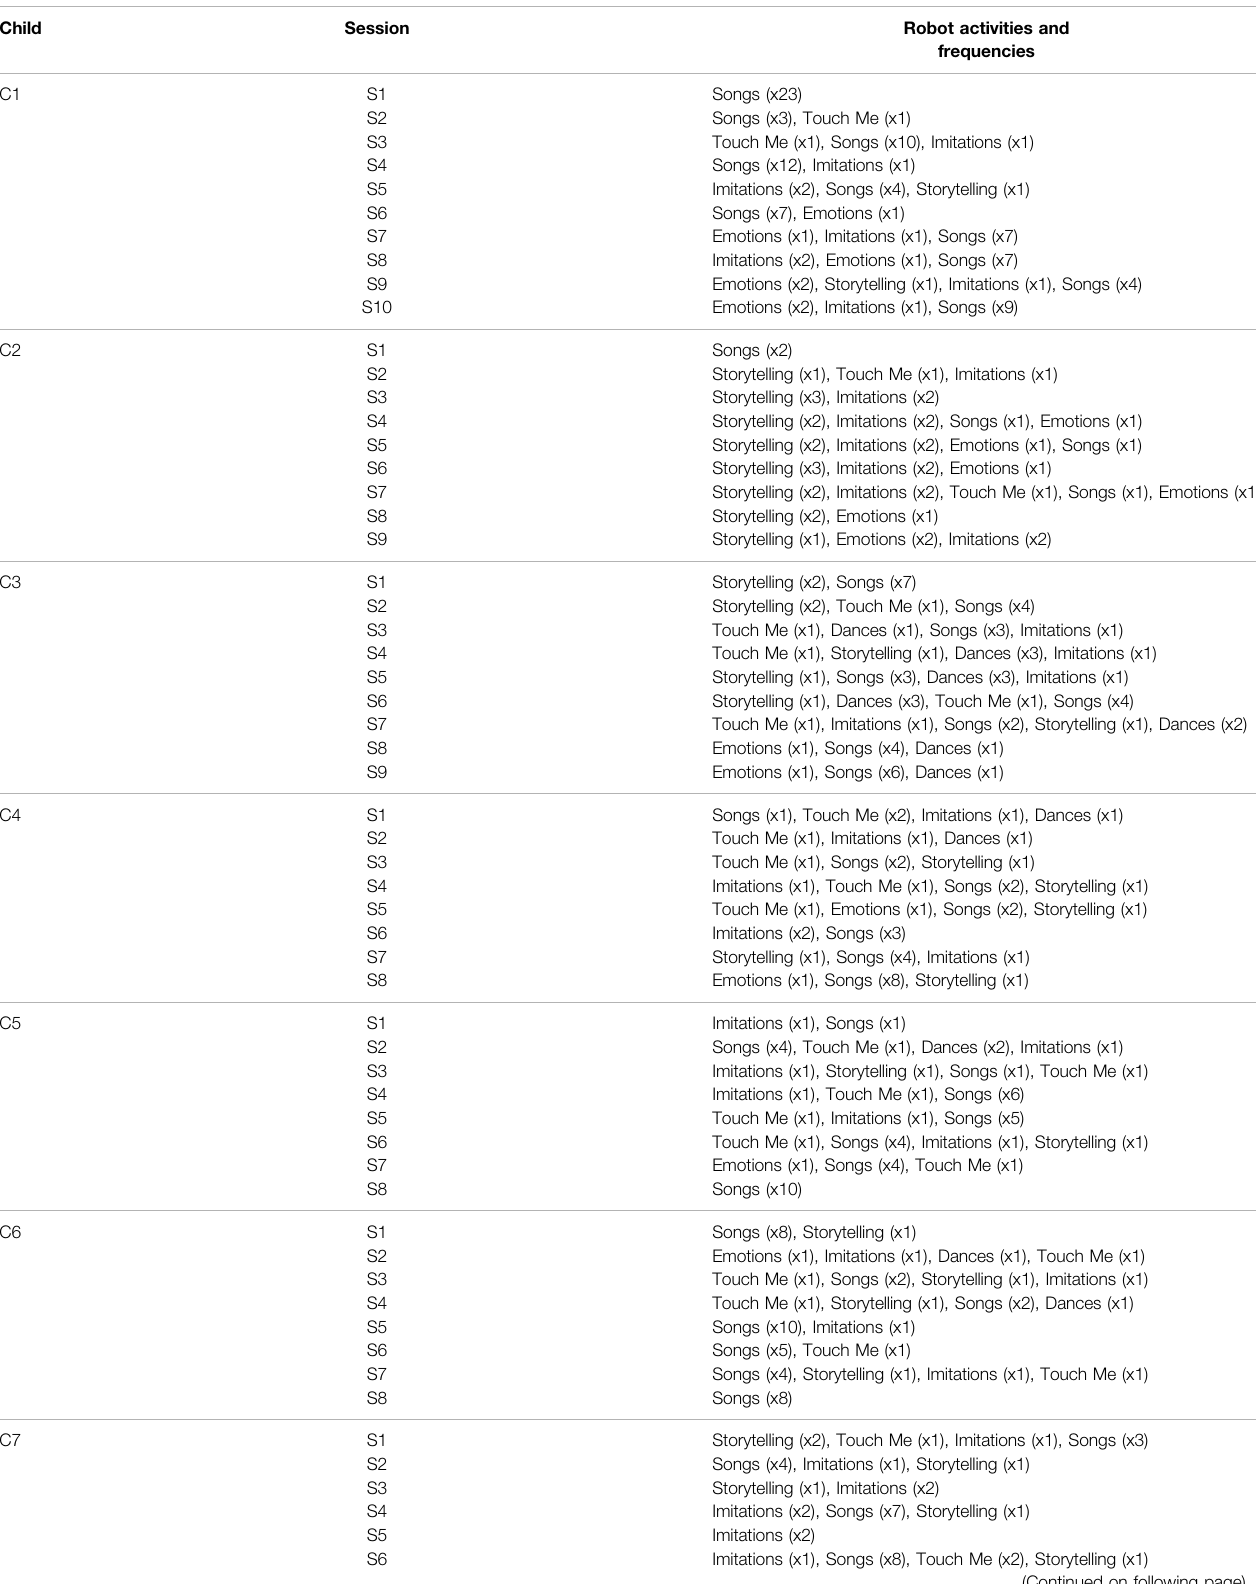
TABLE 2 | Robot activities for each child in each